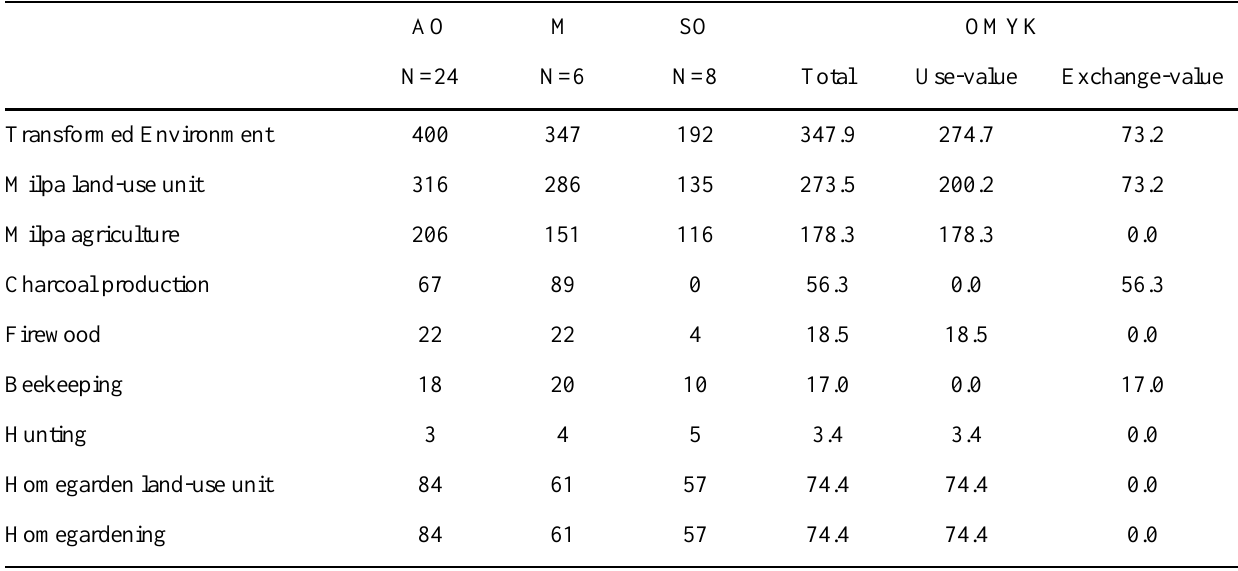
Table 3. Activities and average annual labor allocation by households’ productive strategy and OMYK as a whole in the Transformed Environment (TET). Numbers are per household and based on an 8-hour work